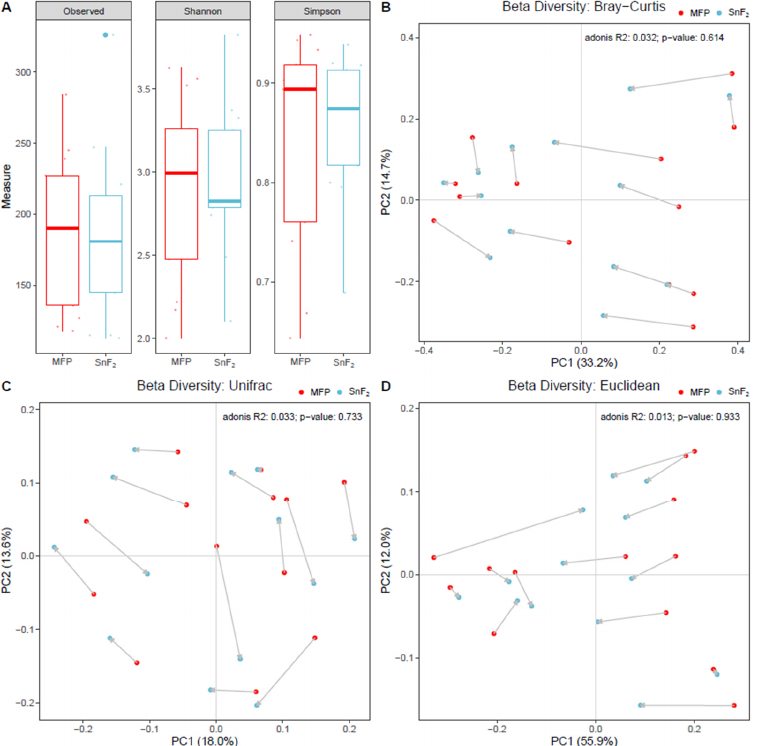
Figure 6. Diversity measurements of oral bacterial community with the use of sodium monofluo- rophosphate (MFP) and SnF 2 -containing toothpastes: ( A ) Boxplots showing alpha diversity of bacterial communities by observed ASVs and measured Shannon and Simpson indices. Each point in the plot is one sample, top and bottom of the box represent upper and lower quartiles, the line is at median, and bars show 95% confidence interval. ( B – D ) Beta diversity Principal Component Analysis (PCoA) plots showing distances of microbial communities in MFP and SnF 2 samples measured using Bray–Curtis, Euclidean, and unweighted-unifrac distance matrices. Each dot represents a sample. R2 and p values calculated by Adonis test for permutational multivariate analysis of variance using distance matrices are shown on the top right of each beta diversity